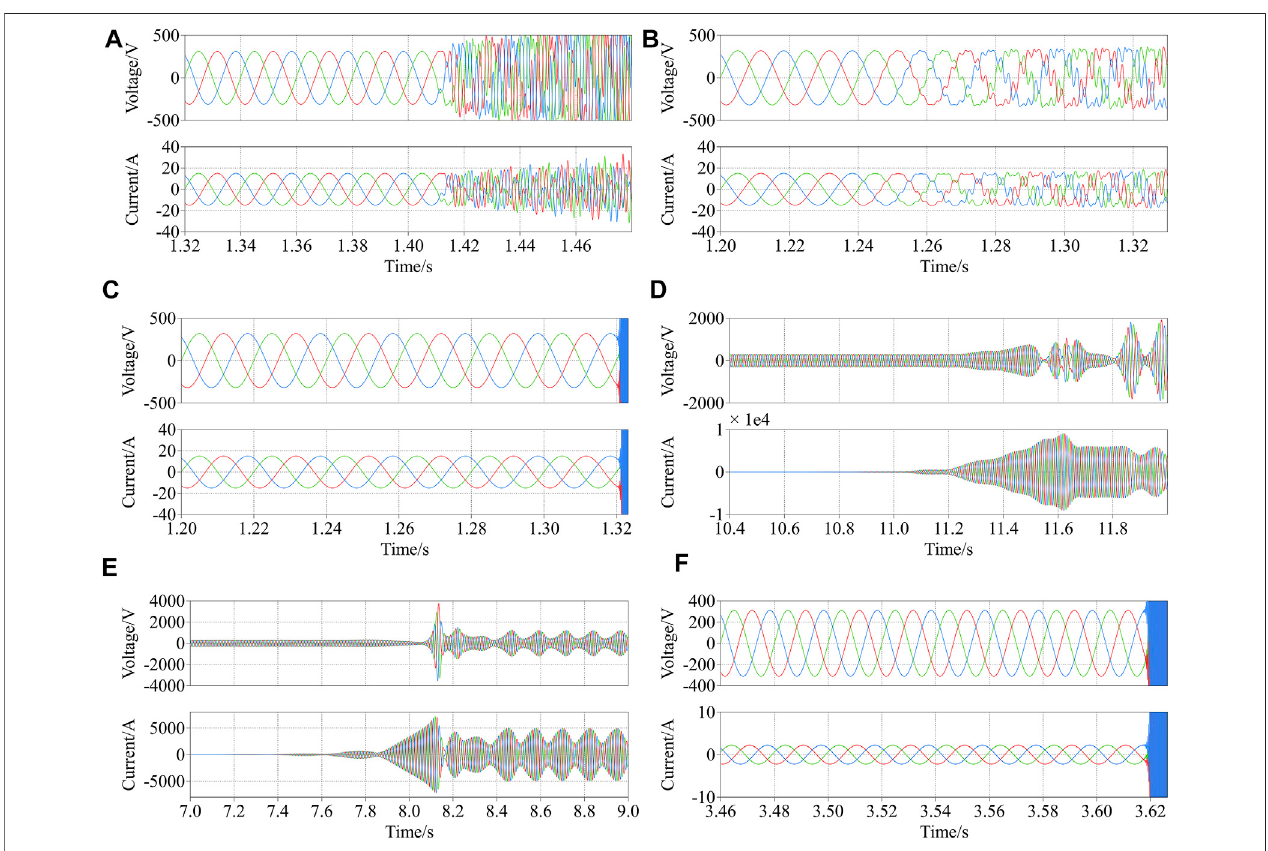
FIGURE 12 | Voltage and current waveforms: (A) R/X ratio is smaller than 1 (PQ node), (B) R/X ratio is larger than 1 (PQ node), (C) k pv (PQ node), (D) R/X ratio is smaller than 1 (PV node), (E) R/X ratio is larger than 1 (PV node), (F) k pv (PV node).